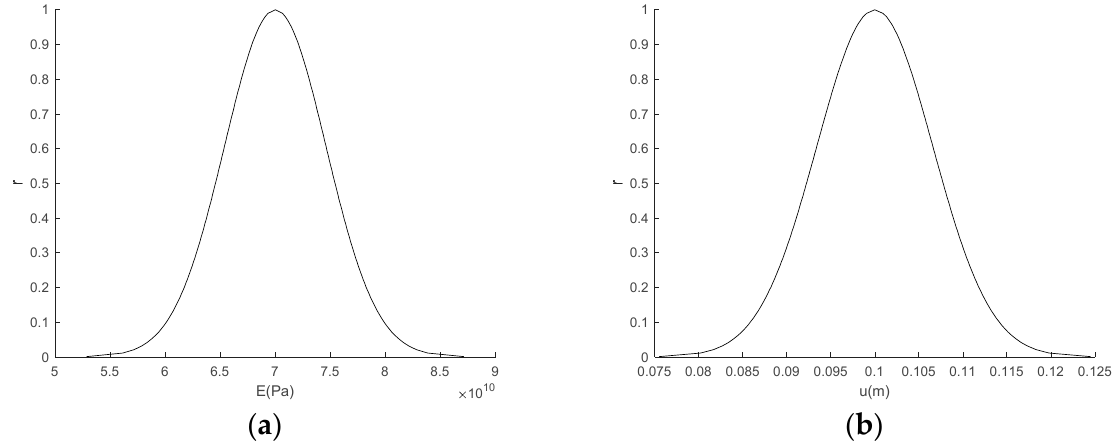
Figure 3. Normal membership functions of ( a ) Young’s modulus ( E ) and ( b ) allowable transverse displacement ( u ). Using the suggested PSIBDO, the results of the optimum solutions for the aircraft wing Table 2. Optimum solutions for the aircraft wing design. design are given in Table 2. The deterministic results for an optimum design variables are prescribed as PSI π fimax = 1. The aeroelastic results corresponds to PSIs as less